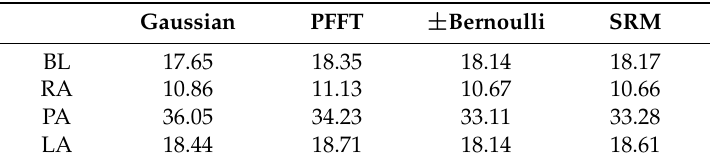
Table 4. Average execution time (ms) of encoder for different structures using different measurement matrices.